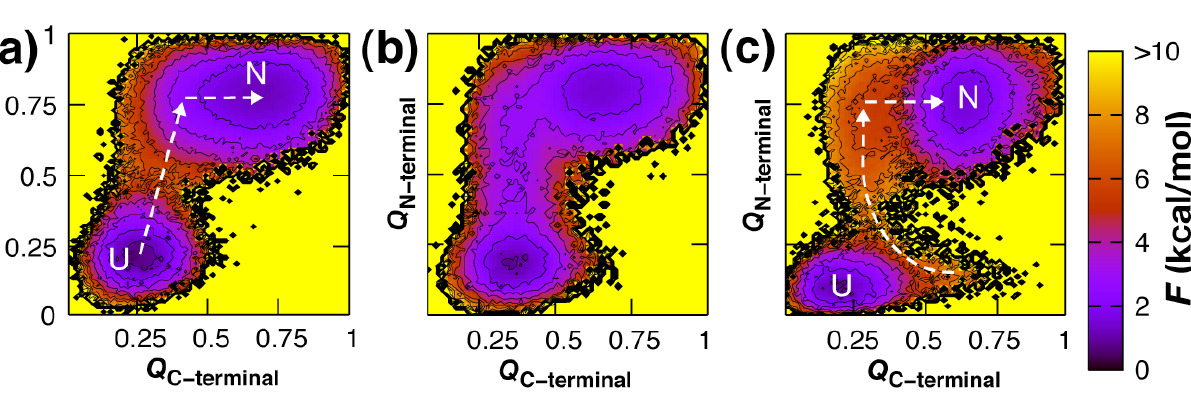
) and C-terminal ( Q ) N-terminal C-terminal